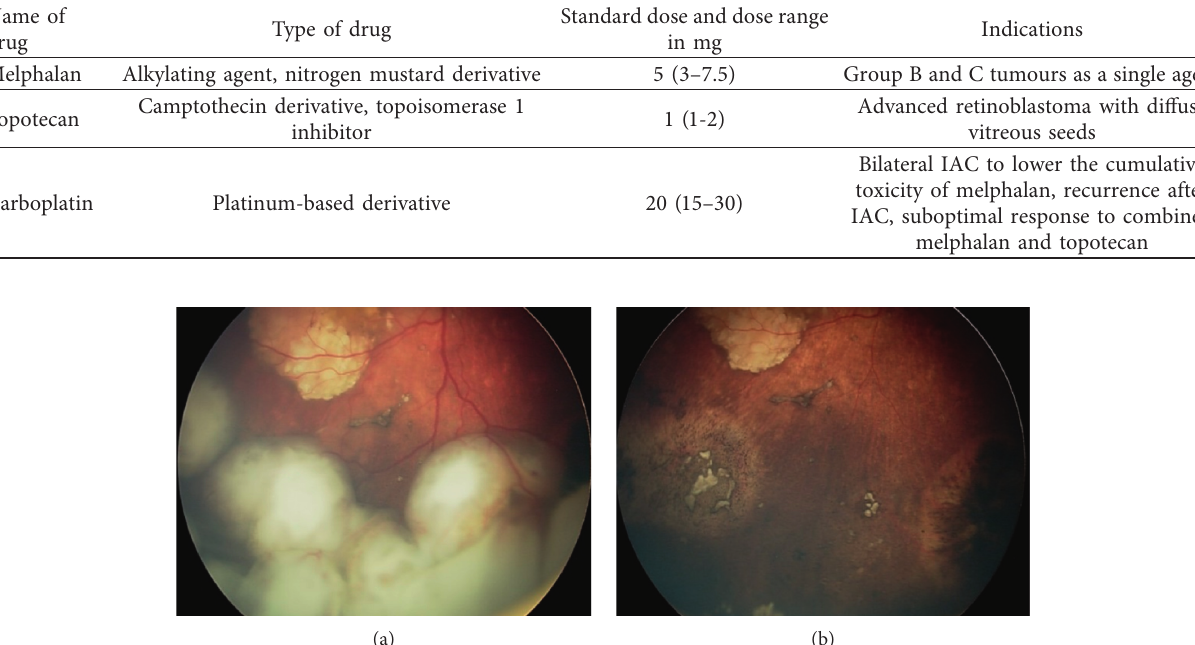
Table 4: Summary of IAC chemotherapeutic agents